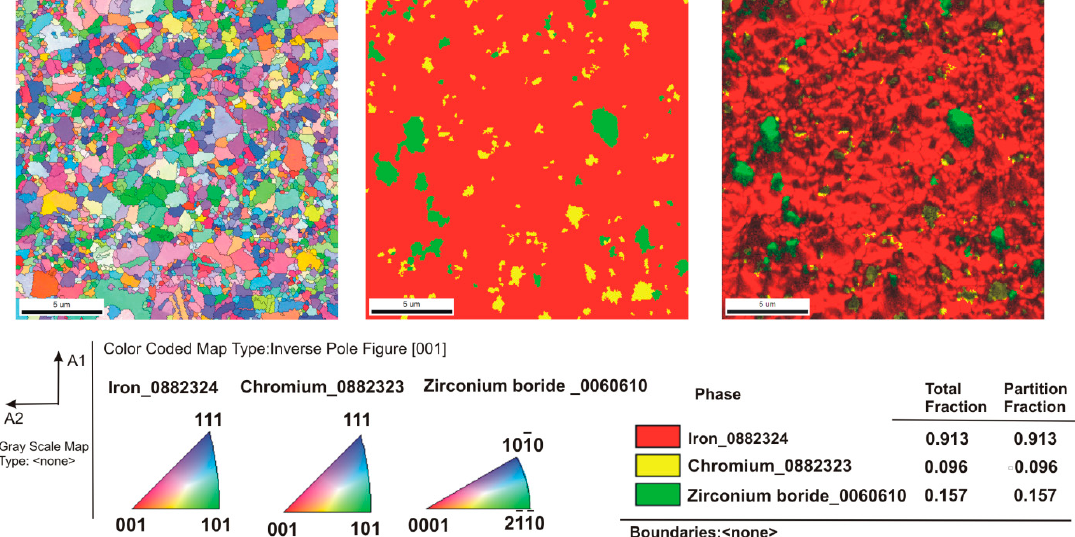
Figure 6. The EBSD maps of the steel+5% ZrB 2 composite.